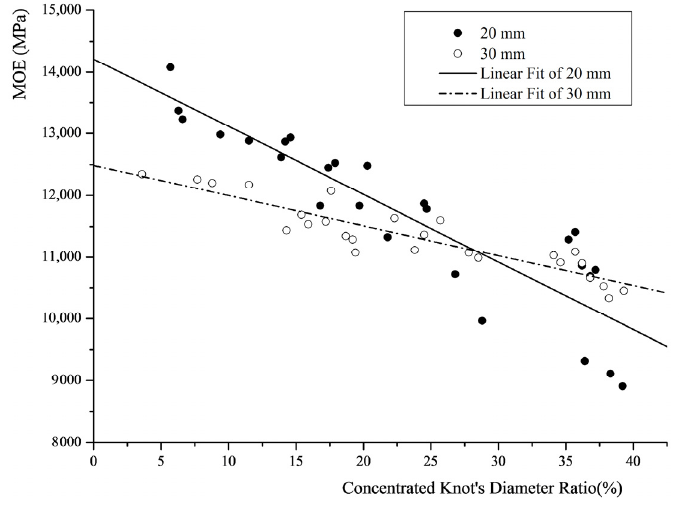
Figure 1. MOE of sawn lumber versus the concentrated knot’s diameter ratio.